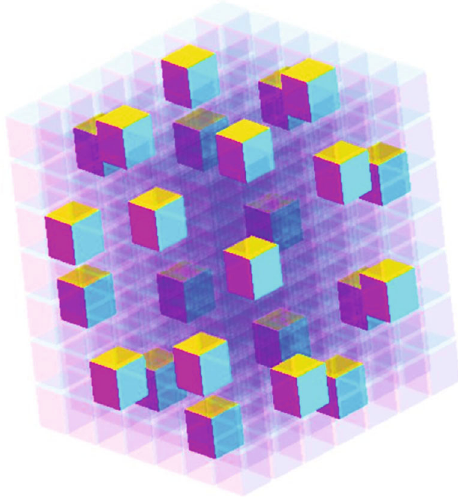
Figure 6: Typical cluster, containing 24